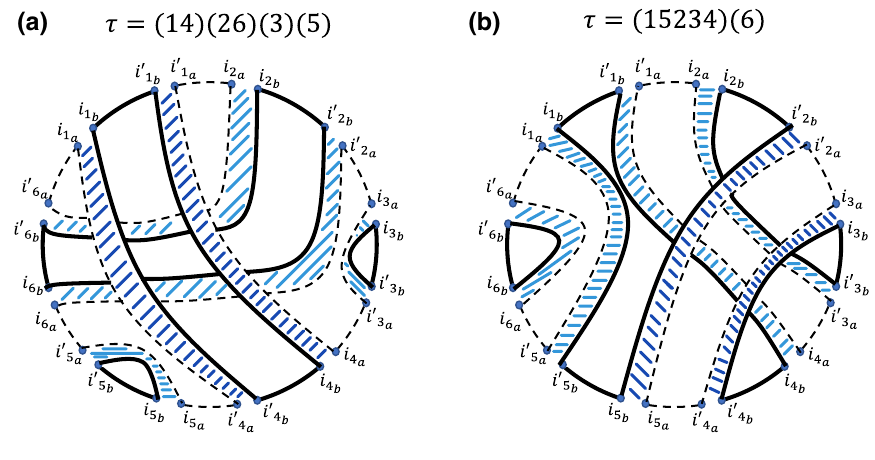
FIG. 4. Examples of nonplanar dia- grams corresponding to two choices of τ that do not saturate Eq.